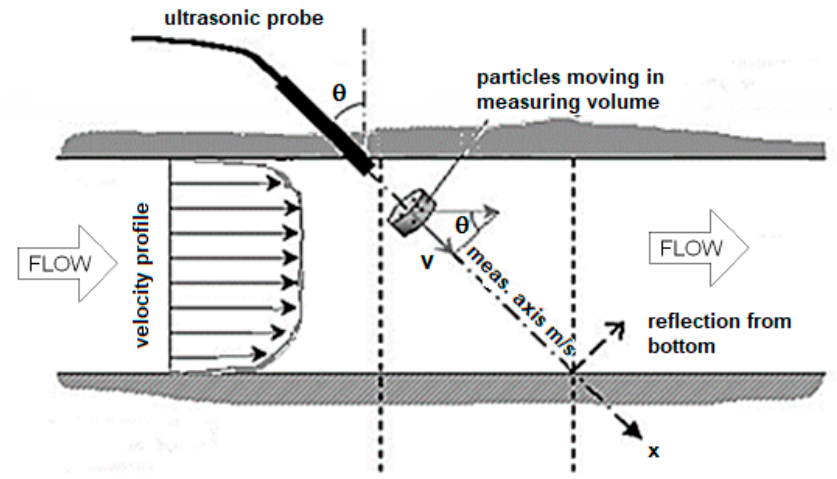
Figure 6. Ultrasonic Doppler velocimetry (UDV) operating principle (adapted from [12]).